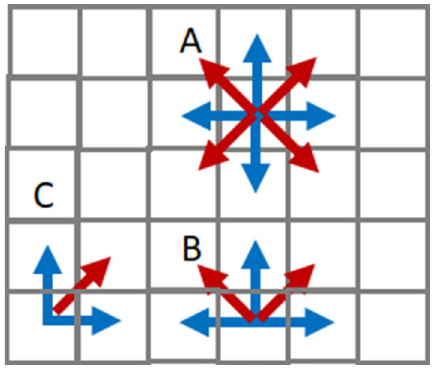
Figure 4. ( A ) The blue and red arrows point to adjacent cells with the rook and queen constraints, respectively. ( B ) At the boundary, the number of adjacent cells under the rook constraint is 3, whereas the number of adjacent cells under the queen constraint is 2. ( C ) At the corner, the number of adjacent cells under the rook constraint is 2, whereas the number of adjacent cells under the queen constraint is 1.